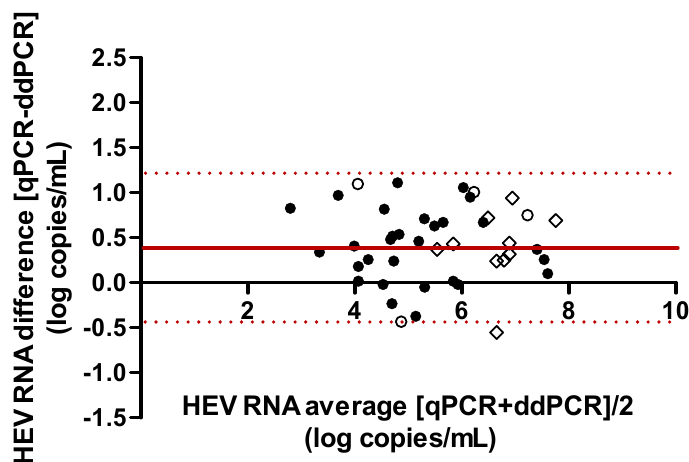
Figure 2. Agreement between HEV RNA concentrations measured by RT-qPCR and RT-ddPCR. Bland-Altman plots comparing HEV RNA quantified by RT-qPCR and RT-ddPCR. Solid lines show the mean of the differences ( n = 0.42 log HEV RNA copies/mL) and broken lines show the mean ± 2 standard deviation. Empty circles designate genotype 1, full circles indicate genotype 3 and squares indicate genotype 4. The two samples not assayed by RT-ddPCR were excluded from the Bland-Altman analysis.